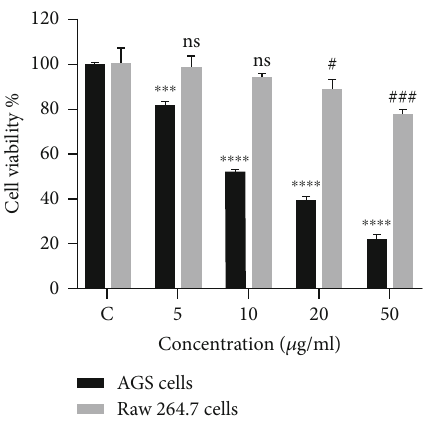
Figure 2: Cell viability of AGS cells and THP-1 cells treated with 5FU. AGS cells and THP-1 cells were cultured in RPMI media and incubated for 24h at 37 ° C. After 24h of incubation, cells were treated with various concentrations of 5FU and incubated for further 24h. After treatment, the media in the plate were removed and replaced with fresh media, and then 10 μ l of WST-1 solution was added in each well, and the plate was incubated for further 4h at 37 ° C. Absorbance was obtained using the ELISA microplate reader at 490nm wavelength. Statistically signi fi cant di ff erence was set at # P < 0 : 05 , ### P < 0 : 001 , ∗∗∗ P < 0 : 001 , and ∗∗∗ ∗ P < 0 : 0001